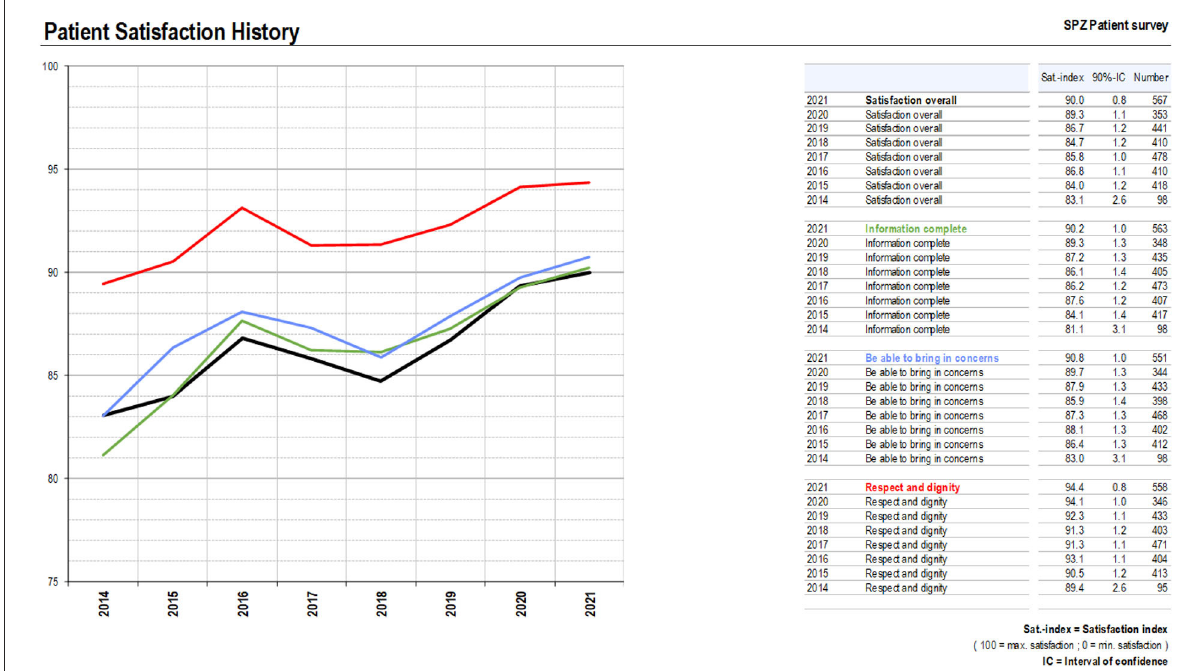
FIGURE1 Patients’ satisfaction measured with an institution-specific questionnaire of an independent institute